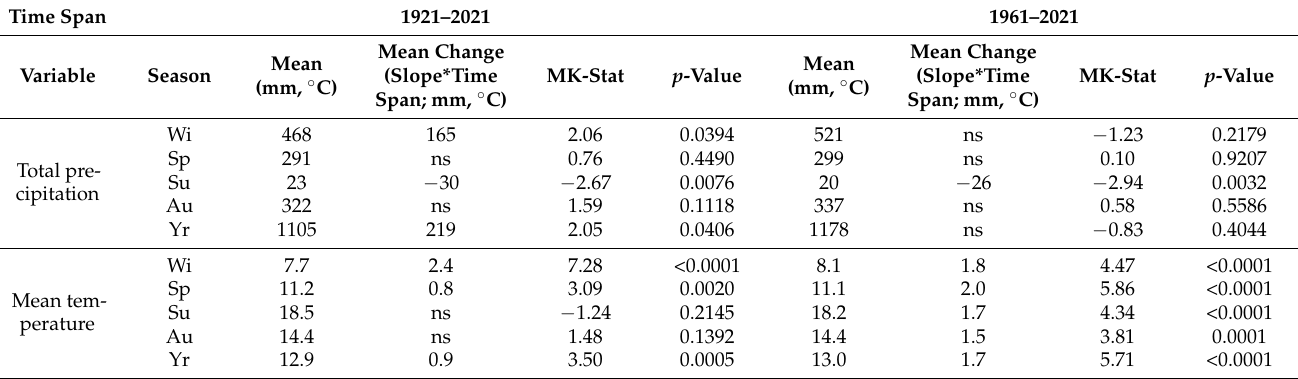
Table 1. Temporal trends observed in seasonal and annual total precipitation and mean temperature according to Mann–Kendall statistic for the period of 1921–2021 and 1961–2021. Seasons are noted as winter (Wi), spring (Sp), summer (Su), and autumn (Au), including December–February, March–May, June–August, and September–November, respectively. Annual estimates consider the hydrological year (prior September to current August). Mean change in each variable over the considered time span was computed, only if the slope was statistically significant, by multiplying the slope estimate (mm or ◦ C year − 1 ) per the number of